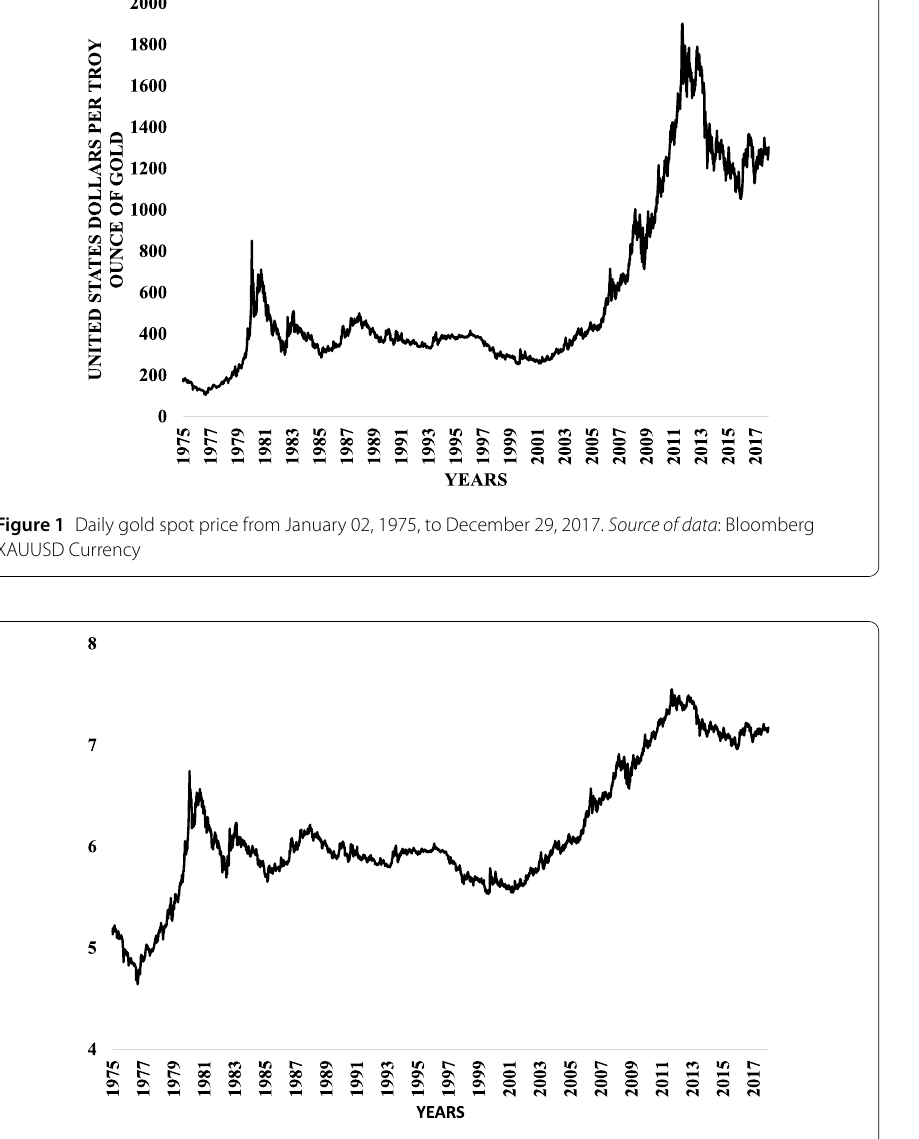
Figure 2 Natural logarithm of the daily gold spot price from January 02, 1975, to December 29, 2017. Source ofdata : Bloomberg XAUUSD